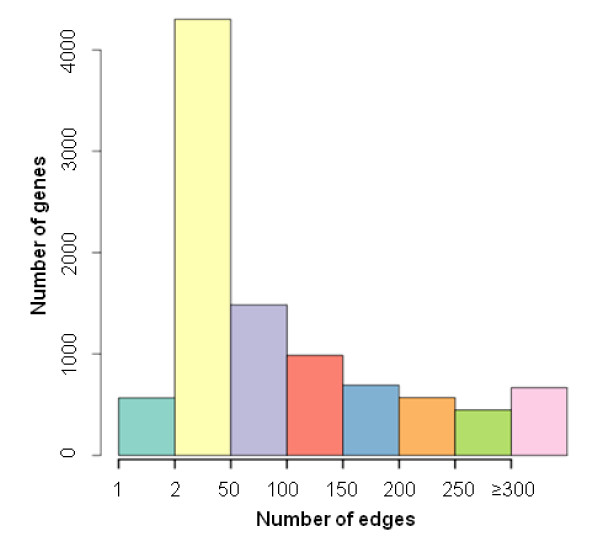
Summary of the gene coexpression network in developing Arabidopsis seeds. Distribution of the number of genes in different bins of edge numbers in the coexpression network of seed-expressed genes. The edge numbers were divided into different ranges and the frequency of nodes in each bin was found to summarize the coexpression network. The bin categories are as follows: 1; 2 - 49; 50 - 99; 100 - 149; 150 - 199; 200 - 249; 250 - 299; and ≥300.